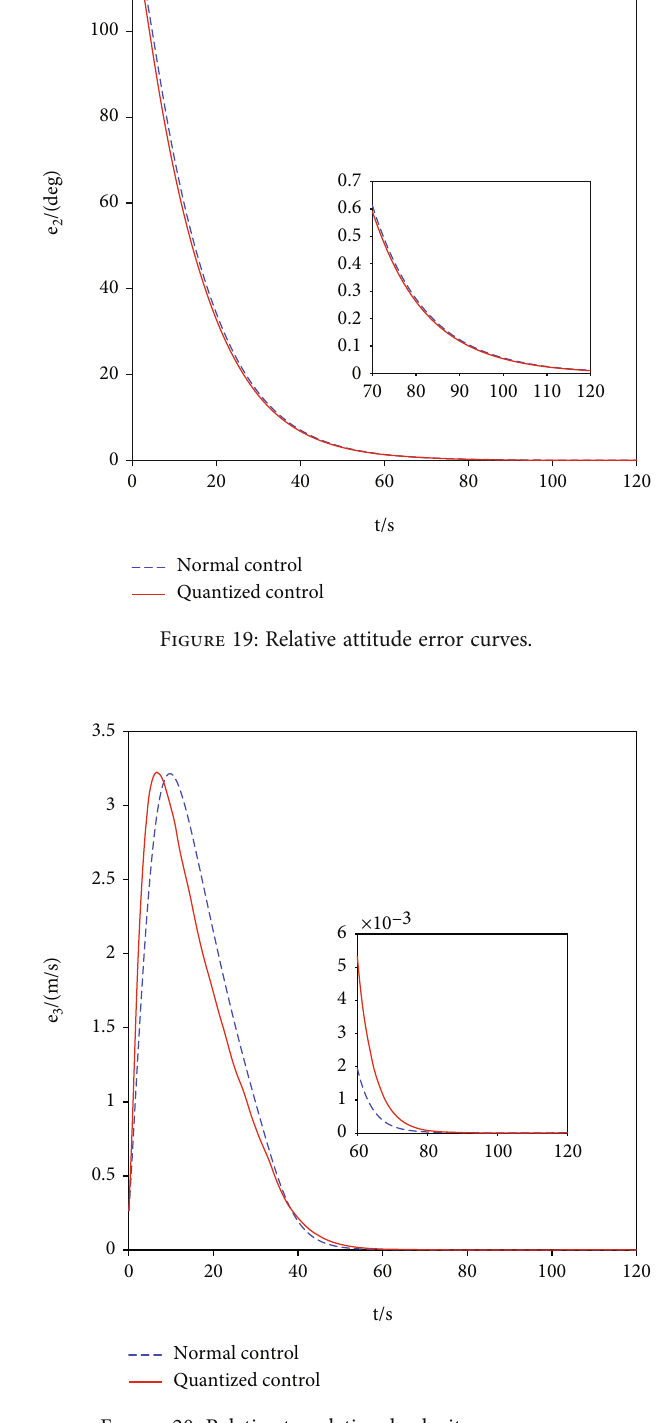
tional velocity tracking error. According to Figure 5, the angular velocity tracking error converges to less than 10 − 3